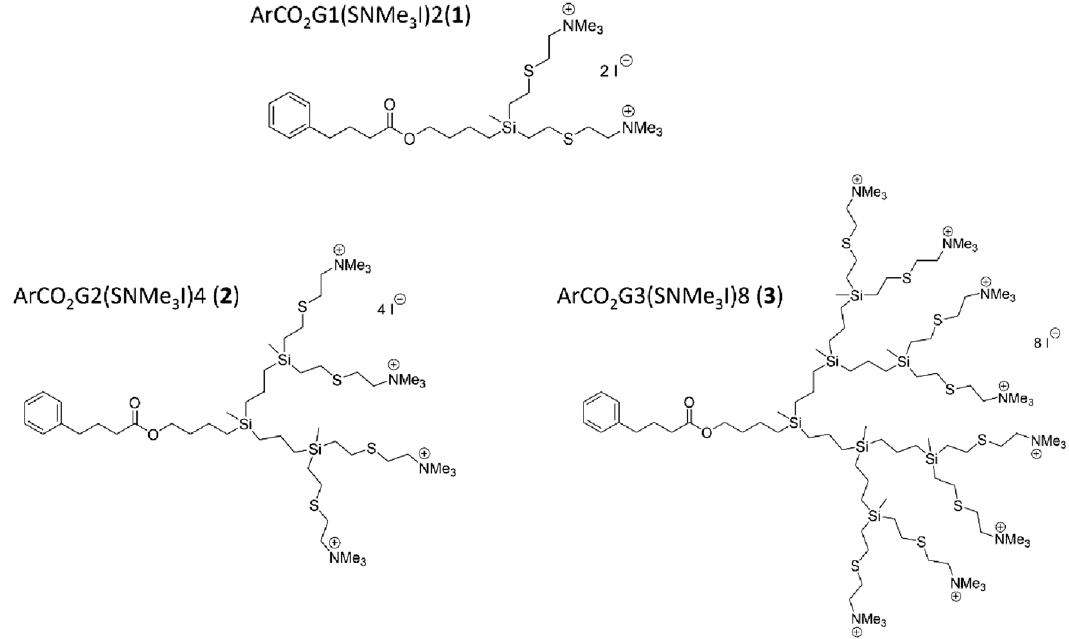
Figure. 1. Structures of cationic carbosilane dendrons derived from 4-phenylbutyric ArCO 2 Gn(SNMe 3 I) m, n: generation, m: number of functional groups. (n = 1, m = 2 ( 1 ): ArCO 2 G 1 (SNMe 3 I) 2 ; n = 2, m = 4 ( 2 ): ArCO 2 G 2 (SNMe 3 I) 4 and n = 3, m = 8 ( 3 ): ArCO 2 G 3 (SNMe 3 I) 8